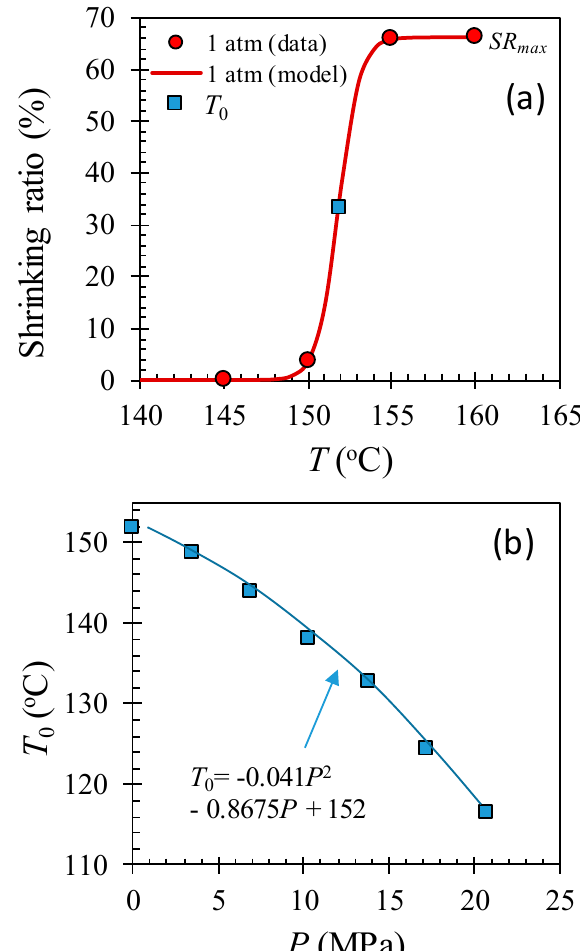
Figure 5. The microfiber shrinkage measurement at various temperatures and pressures in a chamber with/without CO 2 . ( a ) The shrinking ratio at 1 atm as a function of temperature and ( b ) the midpoint of shrinking ratio curve T 0 as a function of CO 2 pressure, which is decreasing with pressure, implying that the shrinking ratio curve shifts toward lower temperature with CO 2 pressure. (Color should be used).